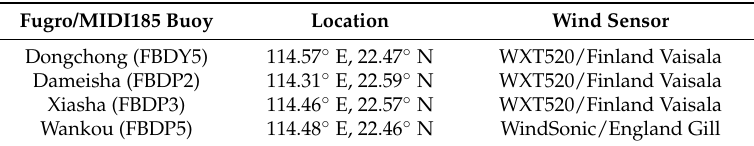
Table 3. The details of the